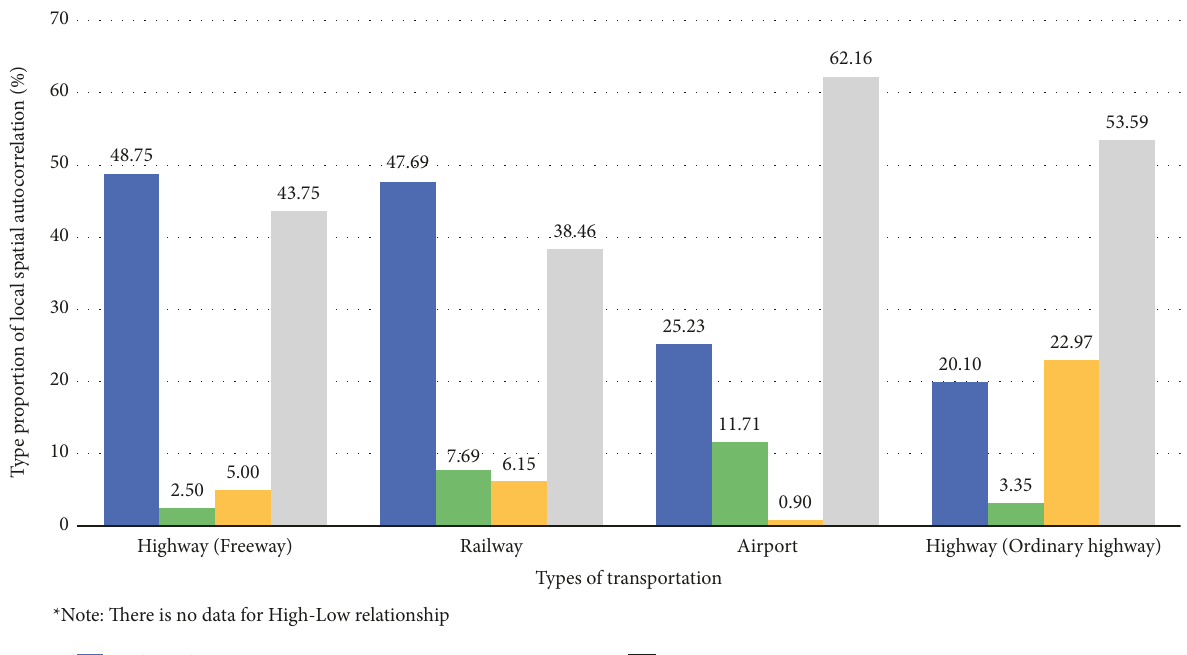
Figure 12: Influence of different types of transportation on spatial pattern of TIID in Qinghai-Tibet Plateau. High-Low